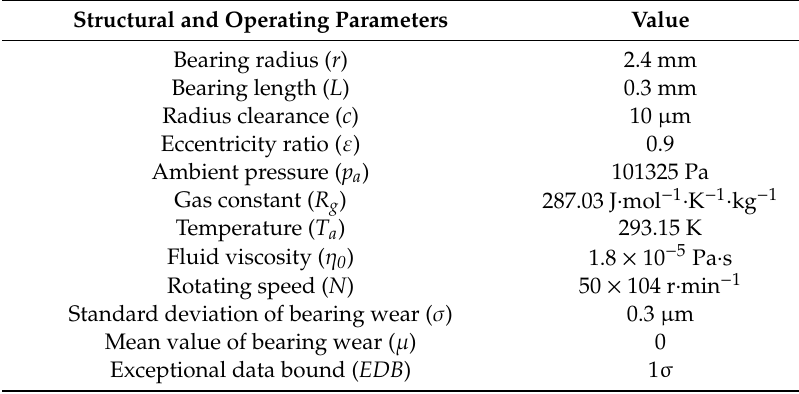
Figure 7. Axial and circumferential distribution of wear. ( a ) axial wear region distribution. ( b ) circumferential wear region distribution. Table 2. Structural and operating parameters of MEMS gas